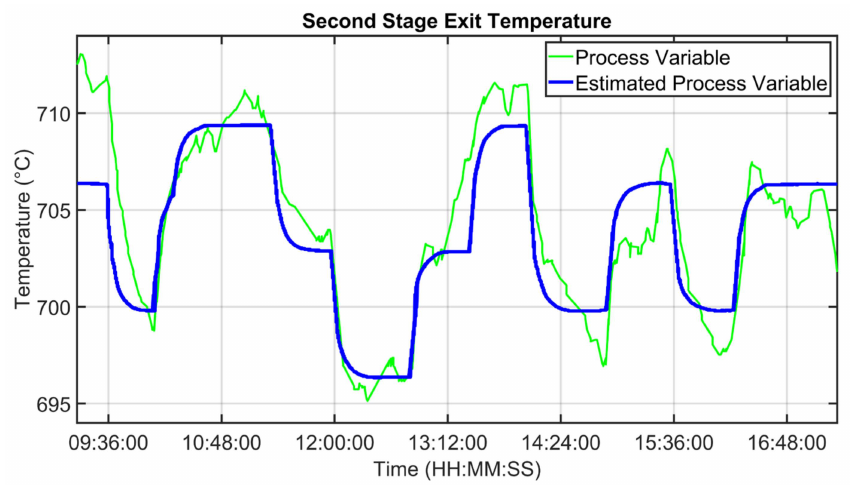
Figure 15. Rotary kiln APC system: modelization results (second-stage exit